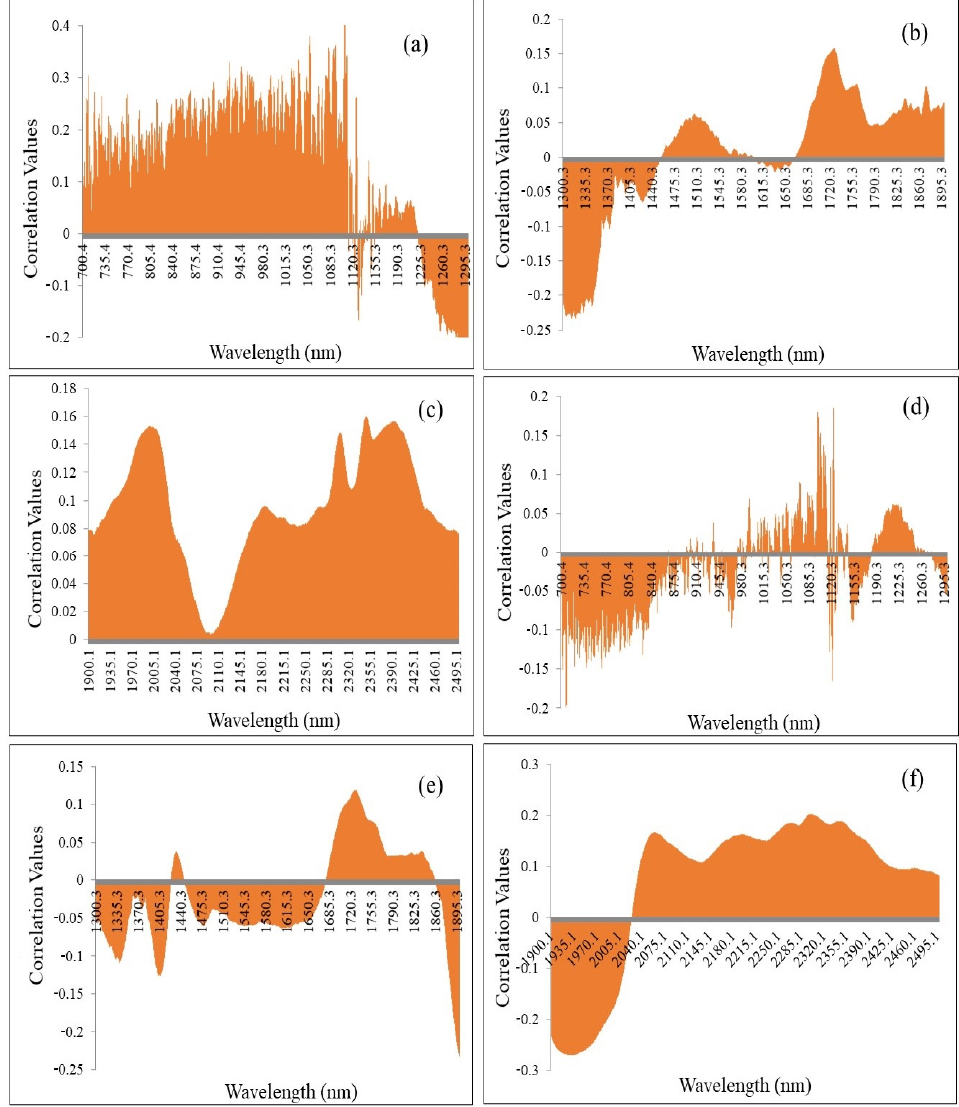
Figure 2. The correlation matrix plots of β -glucan content and NIR spectra in the wavelength